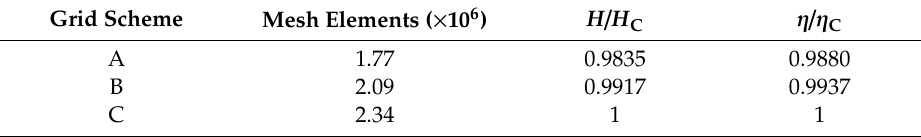
Table 2. Comparison of the performance parameter with di ff erent mesh